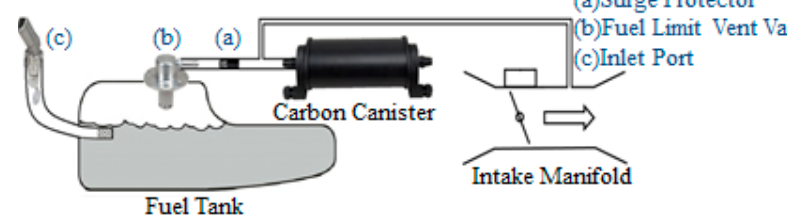
Figure 3. The schematic configuration of the designed ORVR.